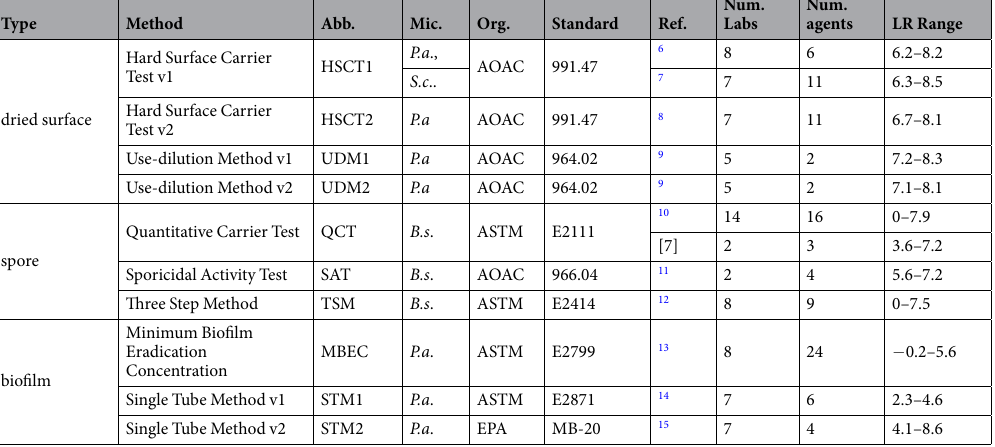
Table 1. Summary of methods reviewed. The summary includes the abbreviation (Abb.) used to refer to each method throughout the paper, the microbe (Mic.) tested, the organization (Org.) that standardized the method, and a reference (Ref.) that describes the method and the associated collaborative study in detail. The microbes used with each method are abbreviated as follows: P.a . for Pseudomonas aeruginosa , S.c . for Salmonella choleraesuis and B.s . for Bacillus subtilis